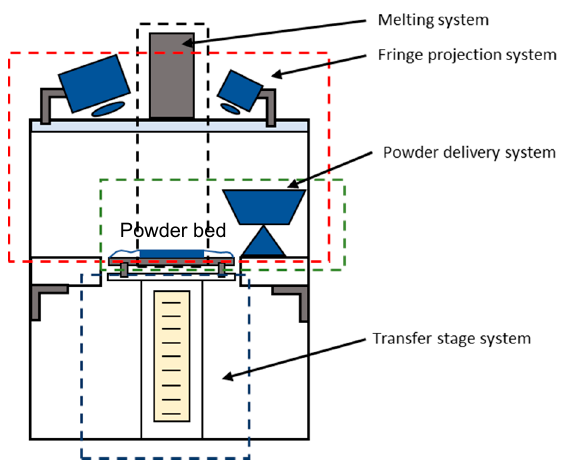
Figure 3. A conceptual setup of the detection system.